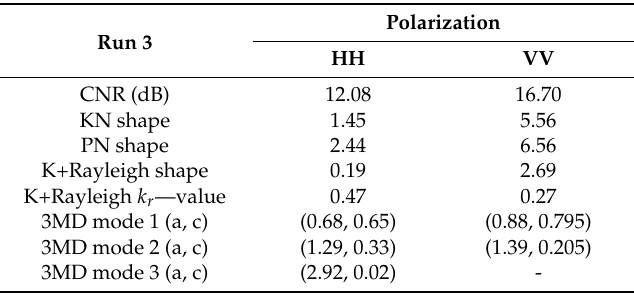
Table 10. Goodness of fit metrics for the model fits in Figure 18. Threshold error is measured at a CCDF of 10 − 4 .